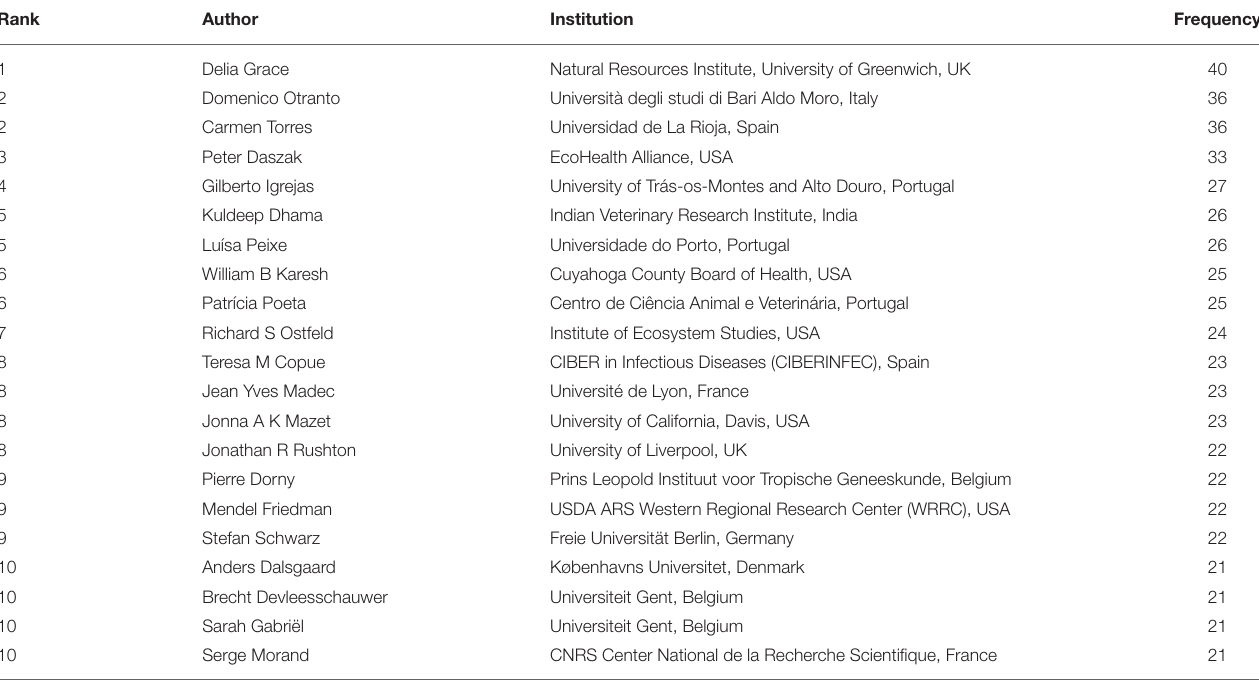
TABLE 2 | Prolific authors in four priority areas of One Health research, 2003–2021.